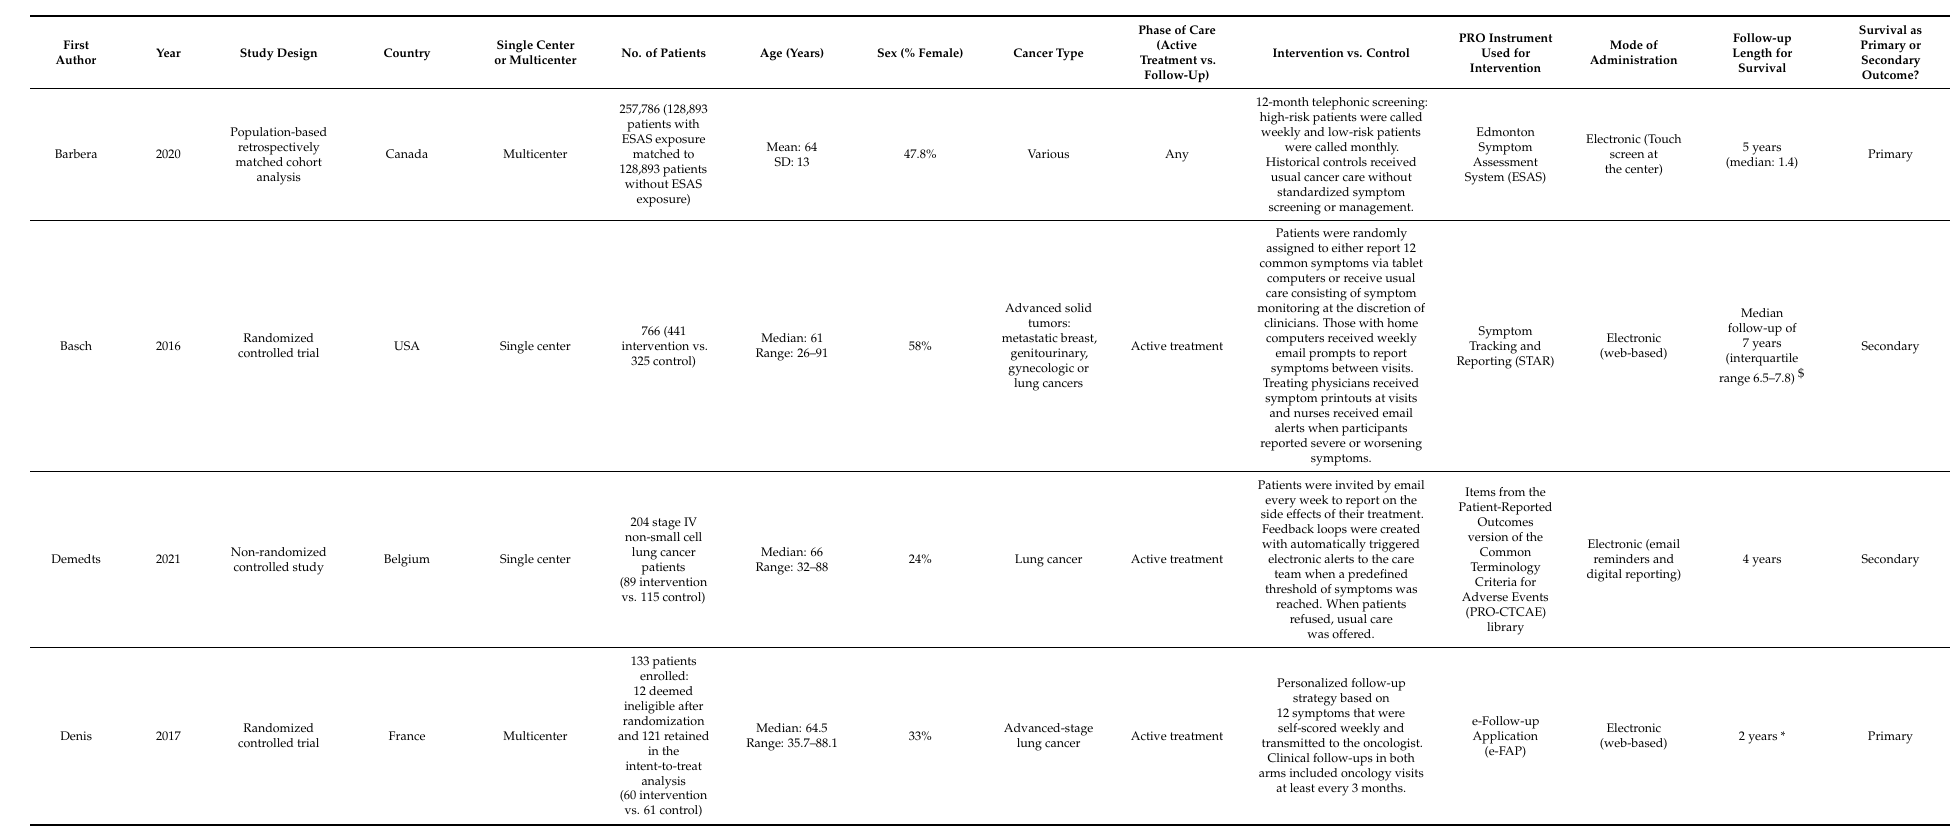
Table 1. Characteristics of included